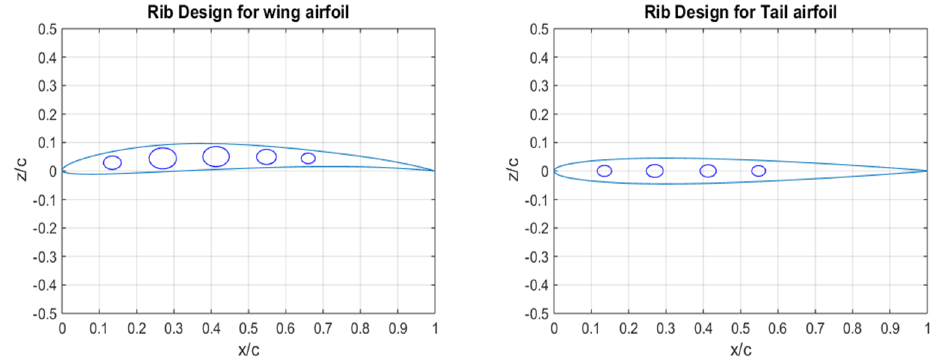
Figure 2. Rib design for wing and tail airfoil.